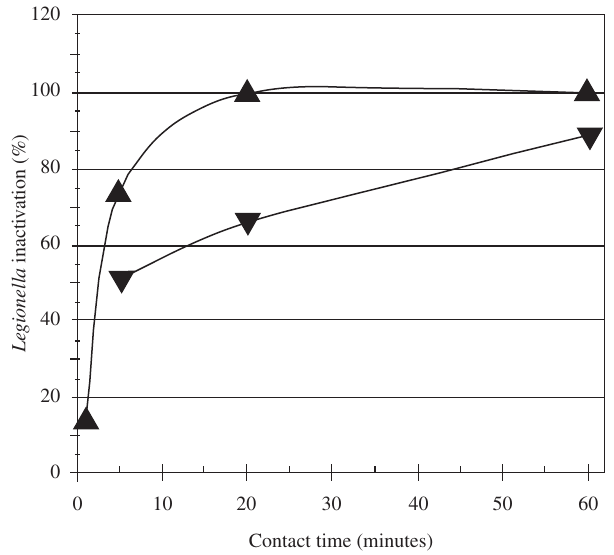
Figure 3. Legionella inactivation with NaOCl and electrolyzed tap water; ( ▲ ) 0.18 ppm oxidant as Cl (tap + NaOCl) and ( ▼ ) 0.19 ppm oxidant as 2 (tap—150 mA.cm –2 ) 29 . Cl 2